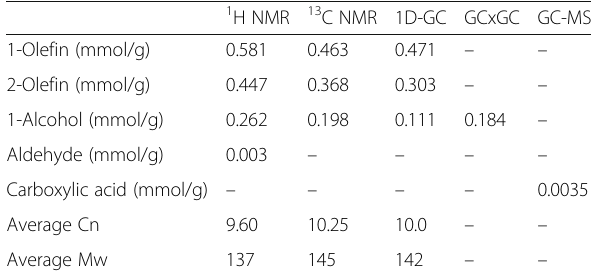
Table 9 Class group quantification across the NMR and GC techniques, LHcL1